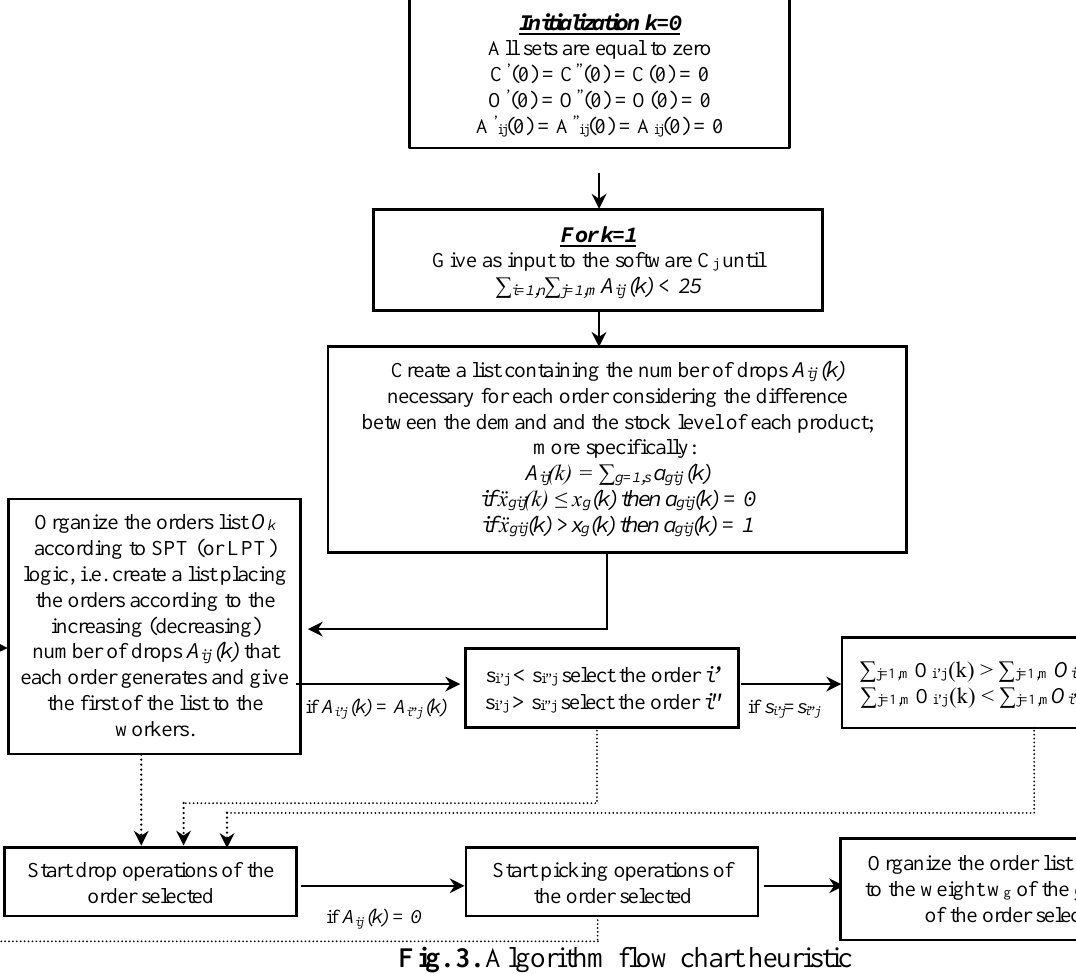
Fig. 3. Algorithm flow chart